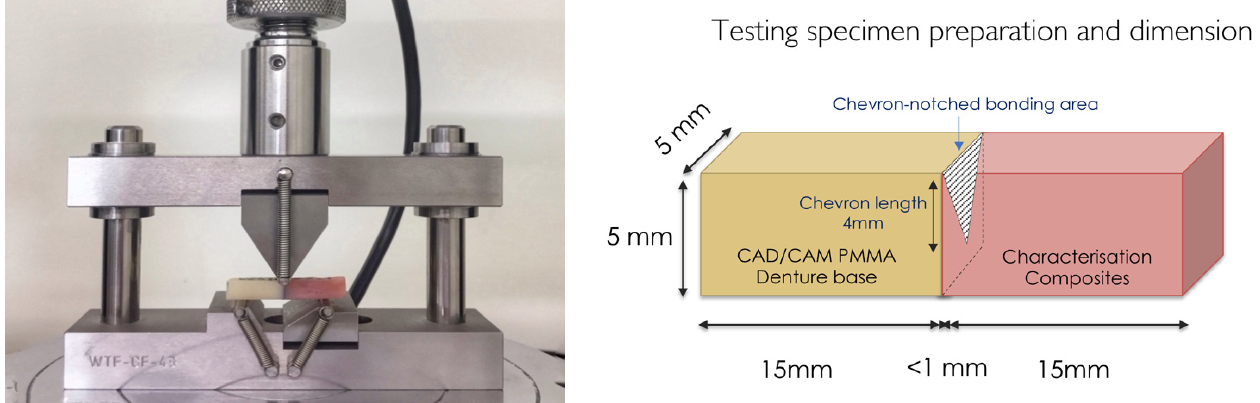
Figure 2. Images showing the chevron-notch three-point bend flexure bond test set up and specimen dimension (Chevron notch dimension is an equilateral triangle with a side of 5 mm).